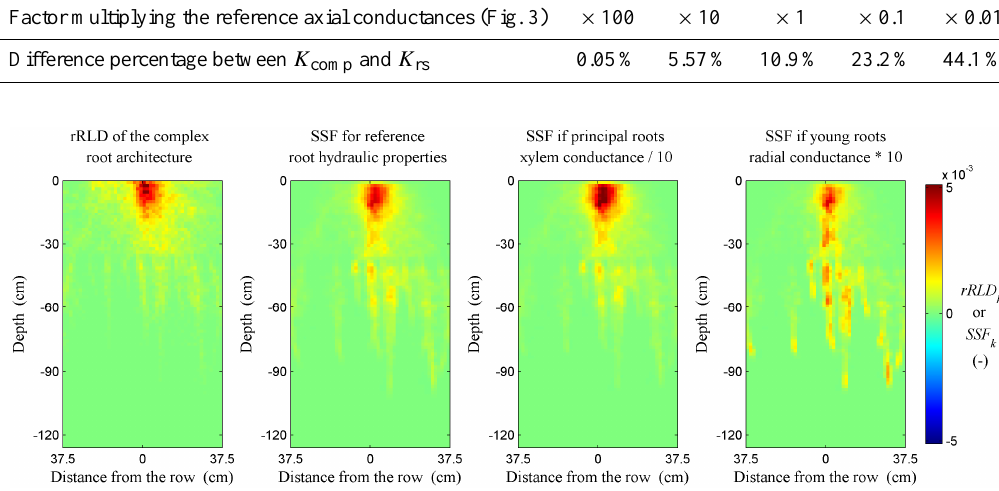
Table 2. Comparison of the values of K comp and K rs for different root axial conductance levels of magnitude (as compared to the reference root hydraulic properties, Fig. 3).